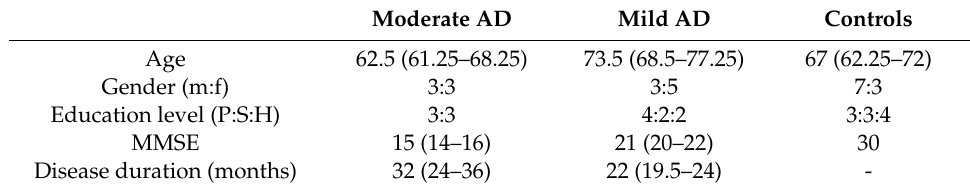
Table 1. The descriptions of participants’ characteristics. Moderate AD Mild AD